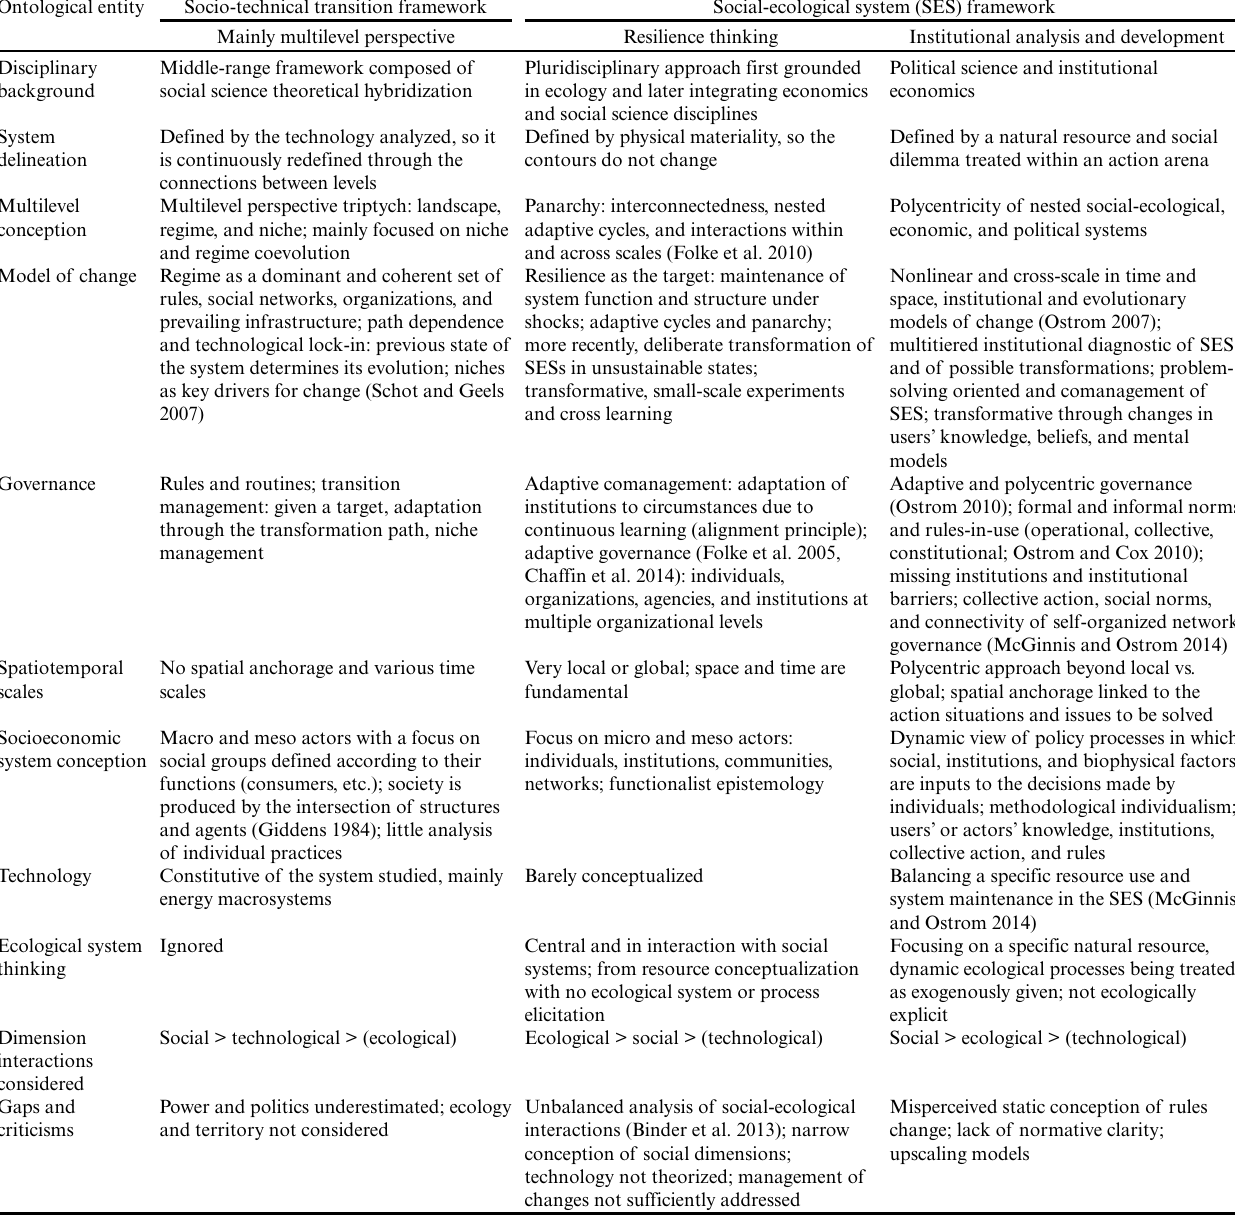
Table 1. Comparison of sustainability transition framework